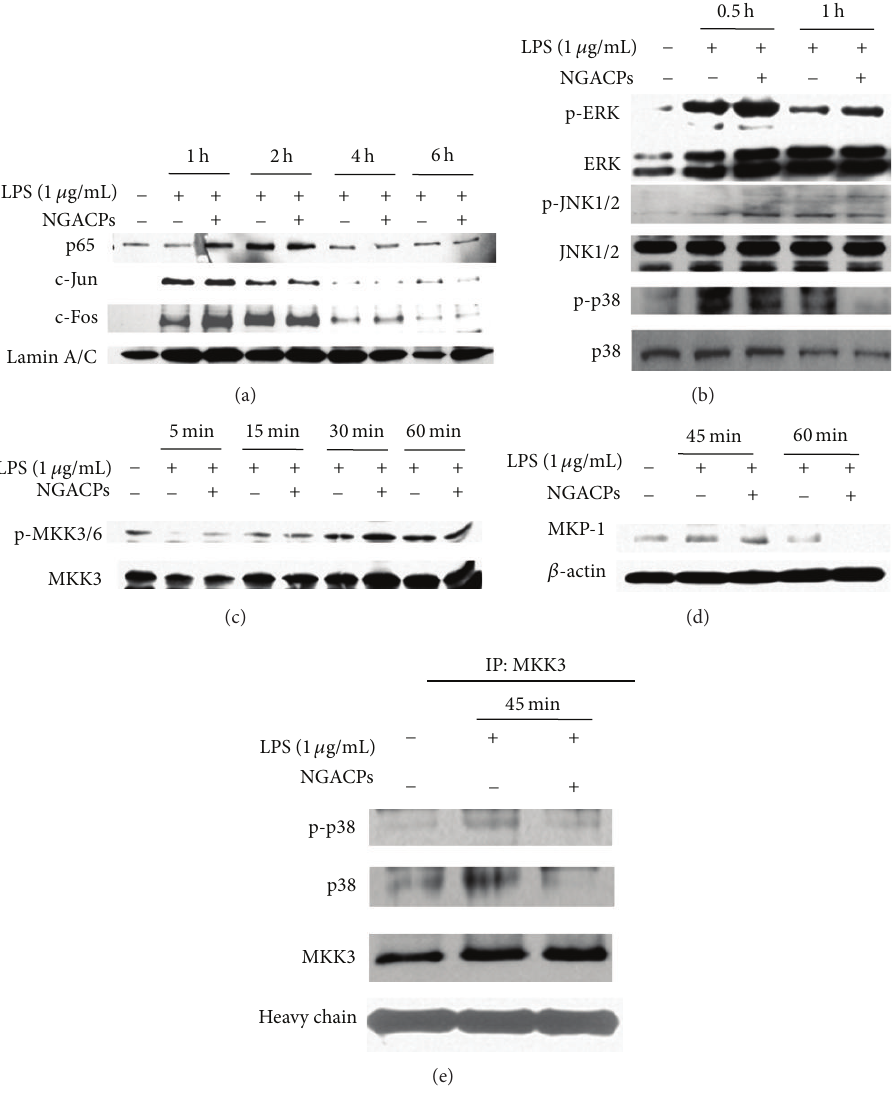
Figure 4: Effect of NGACP on the activation of transcription factors and their upstream signaling events. (a) The levels of transcription factors (p65, c-Jun, and c-Fos) in the nuclear fraction were determined using Western blot analysis of antibodies against total protein. ((b), (c), and (d)) Phosphoprotein or total protein levels of ERK, p38, JNK, MKK3/6, MKP-1, and 𝛽 -actin from cell lysates were determined using Western blot analysis of phospho-specific or total protein antibodies. (e) The molecular complex formation between MKK3 and p38 or p-p38 was evaluated by immunoprecipitation and immunoblotting